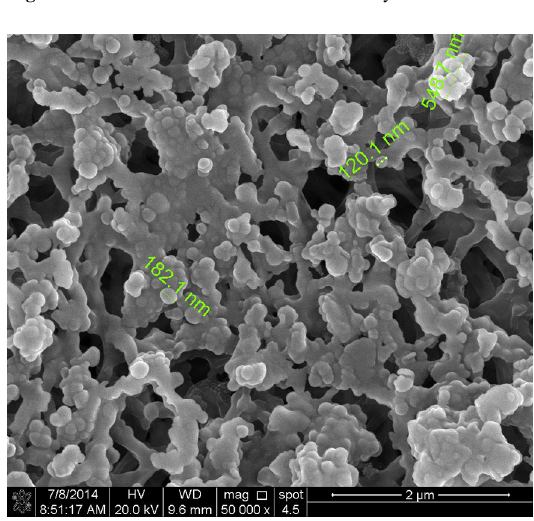
Figure 13. Morphology of maltodextrin PCN (Batch